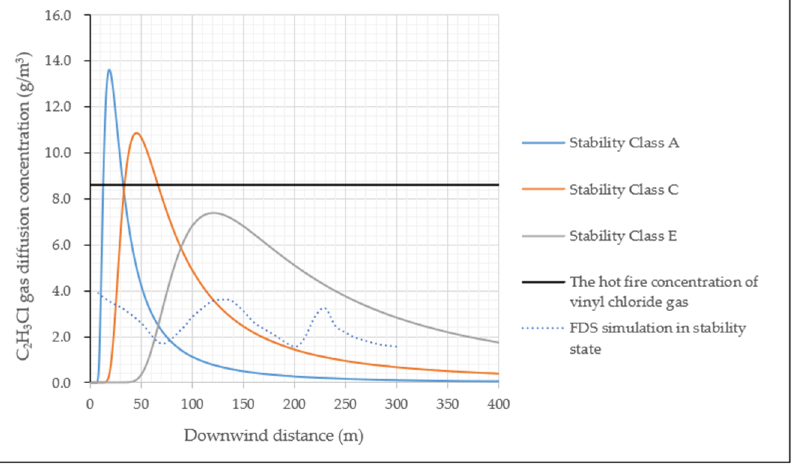
Figure 7. Concentration distribution diagram of MATLAB and FDS simulation methods in down- wind direction.